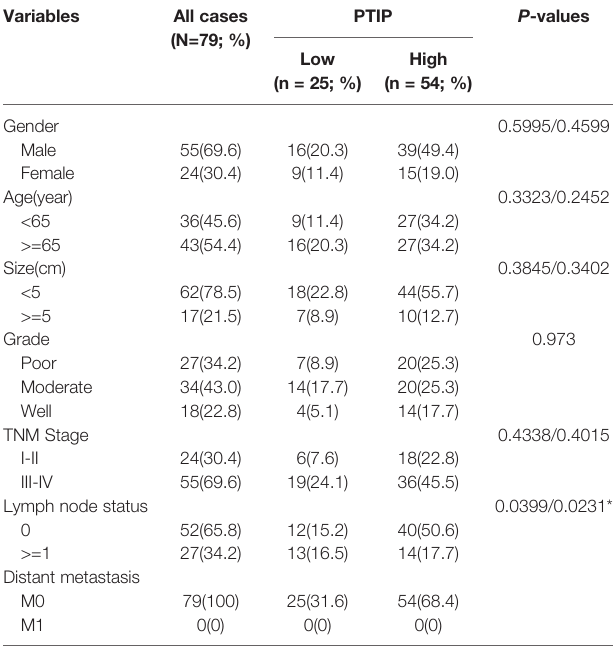
TABLE 4 | Summary of clinical and histopathological characteristics of the 79 esophageal squamous cell carcinoma patients. Variables All cases (N=79;